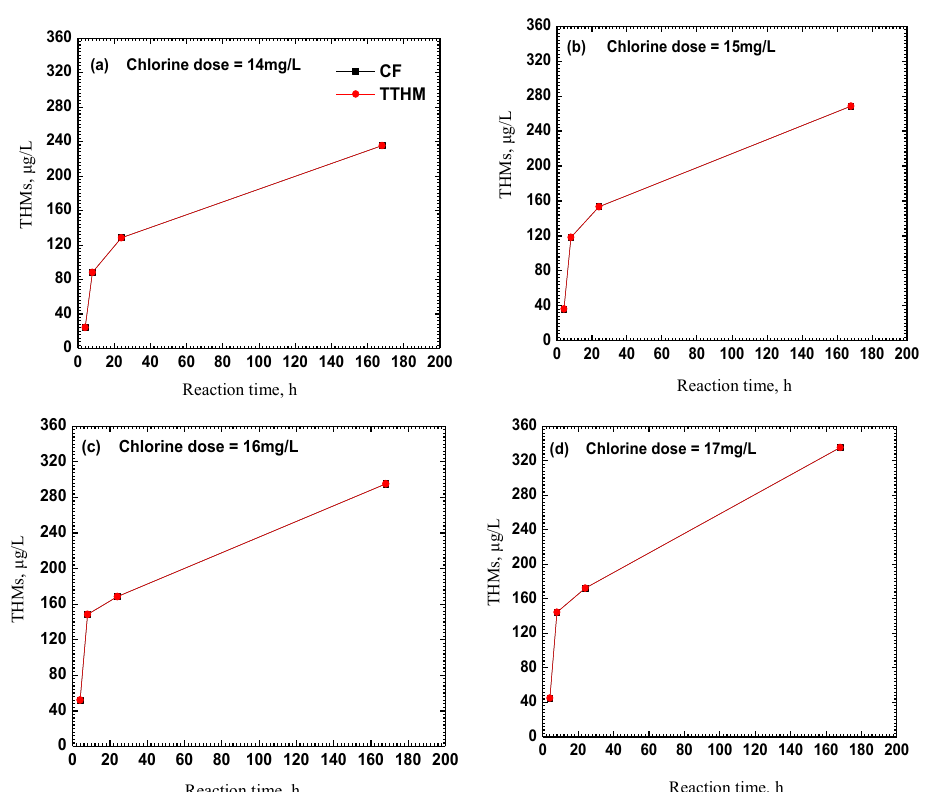
Figure 3. Effect of reaction time on THMs formation at different chlorine doses in the ground water sample collected from Jajmau in May,